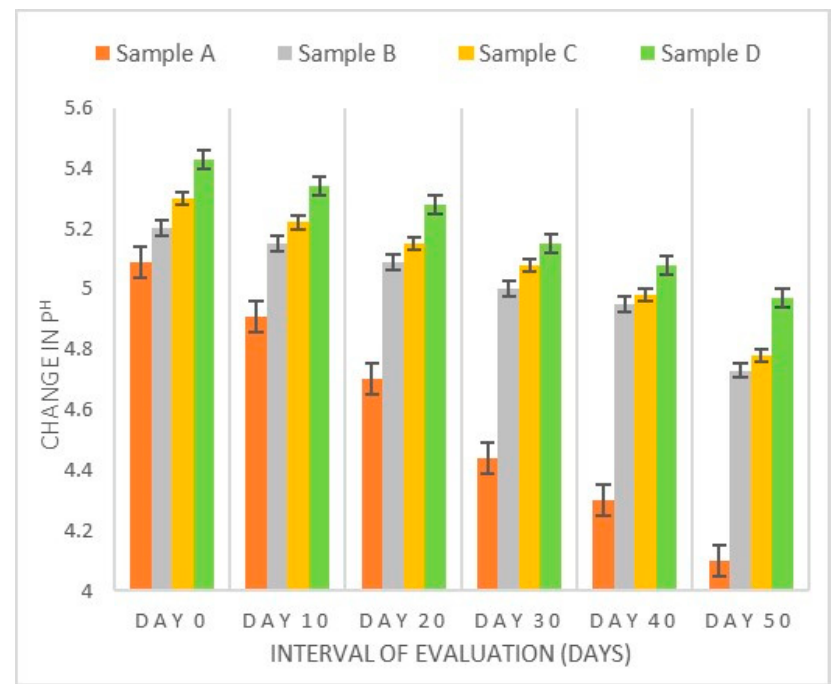
Figure 3. pH evaluation of samples.